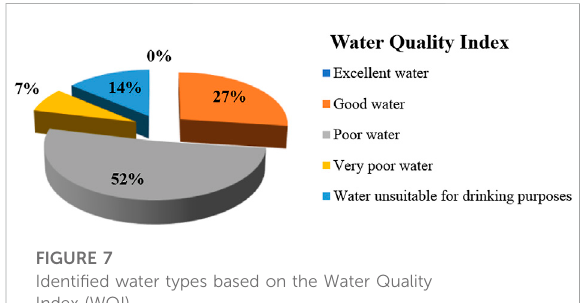
FIGURE 7 Identi fi ed water types based on the Water Quality Index (WQI).